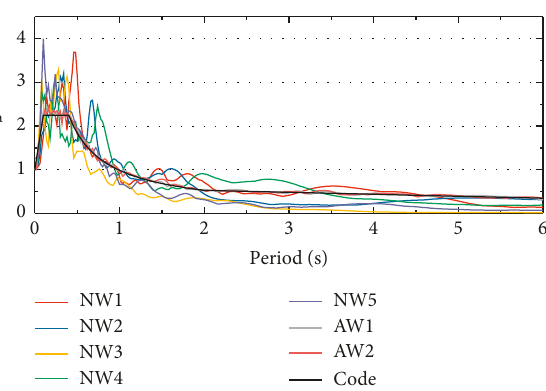
Figure 6: Spectra of normalized input ground motion